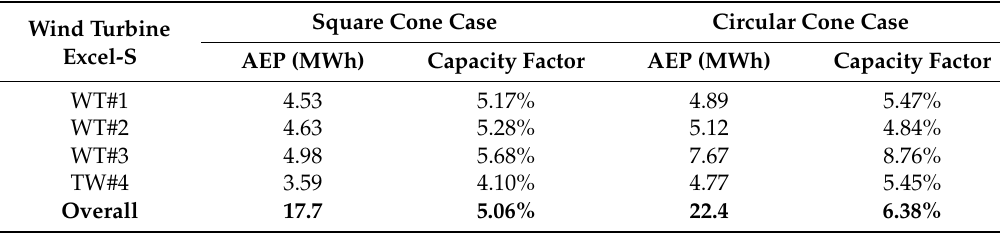
Table 2. The AEP and capacity factor of the horizontal-axis wind turbines.